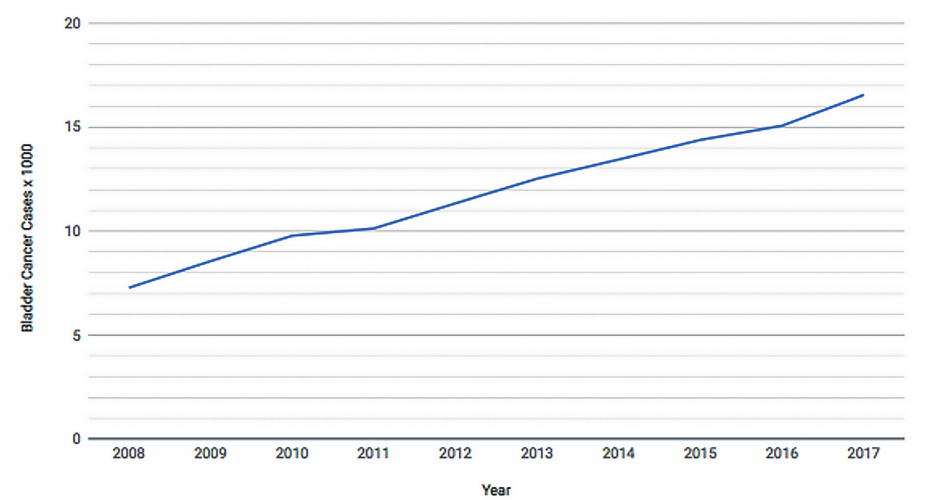
Figure 1 - Bladder Cancer Admissions on Brazilian Public Health System (2008-2017).